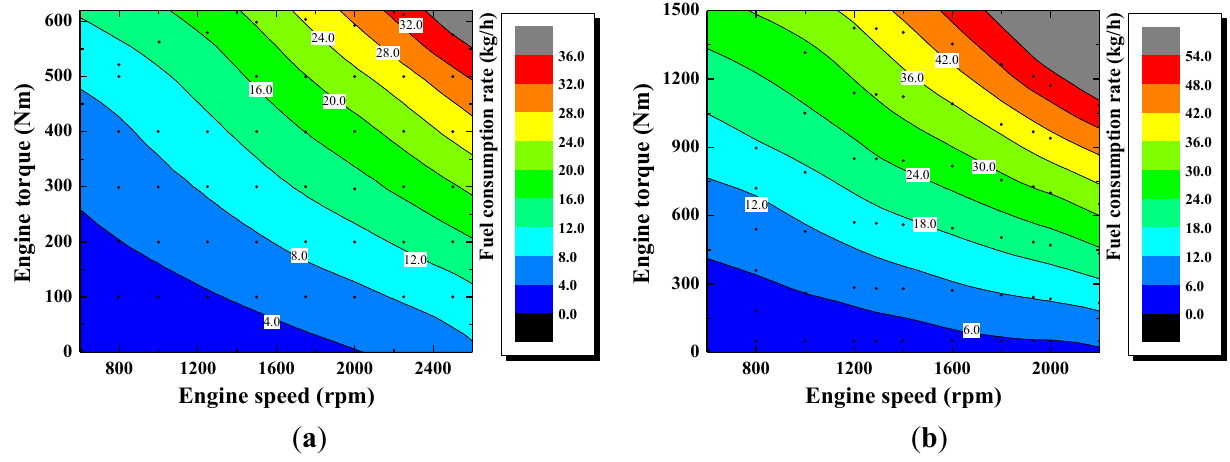
Figure 5. Fuel consumption map data: ( a ) Vehicle A ( b ) Vehicle B.